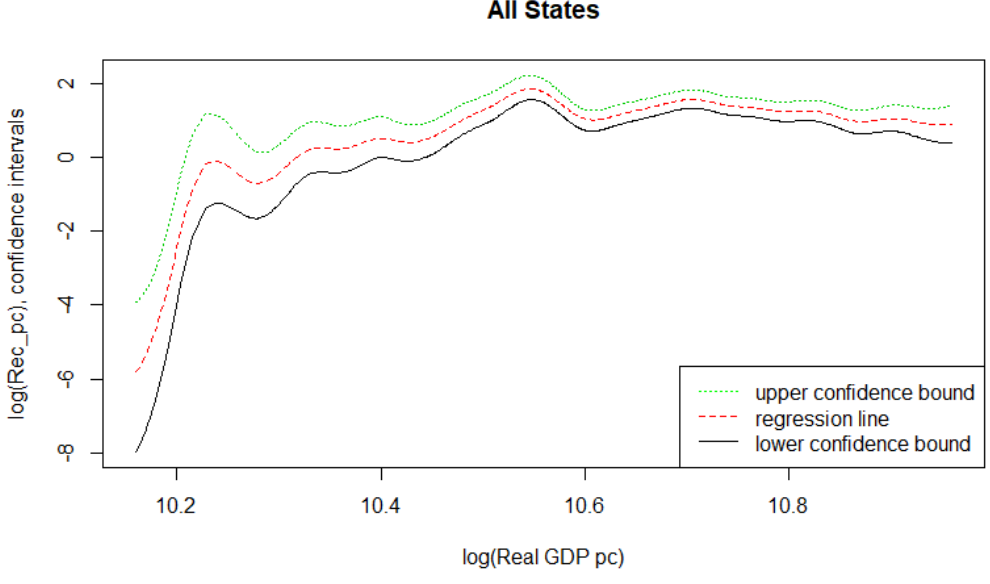
Figure 1. Relationship between Recycling per capita and Real GDP per capita.